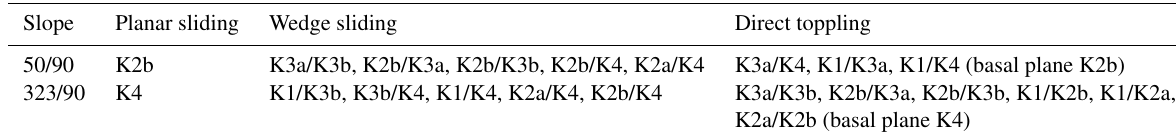
Table 5. Potentially unstable discontinuity systems along the two different slope orientations.